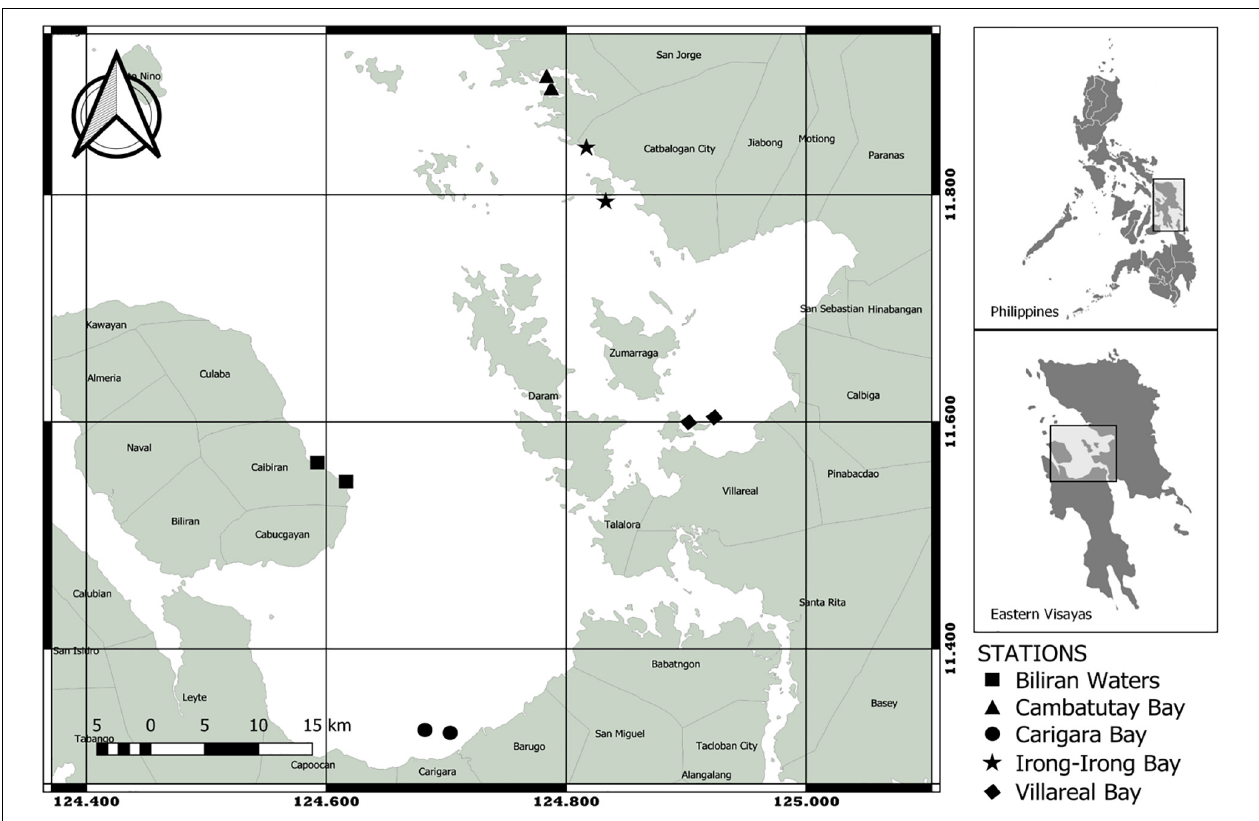
FIGURE 1 | The map of 10 stations surveyed for phytoplankton composition in Eastern Visayas, Philippines. Sampling sites are designated in different